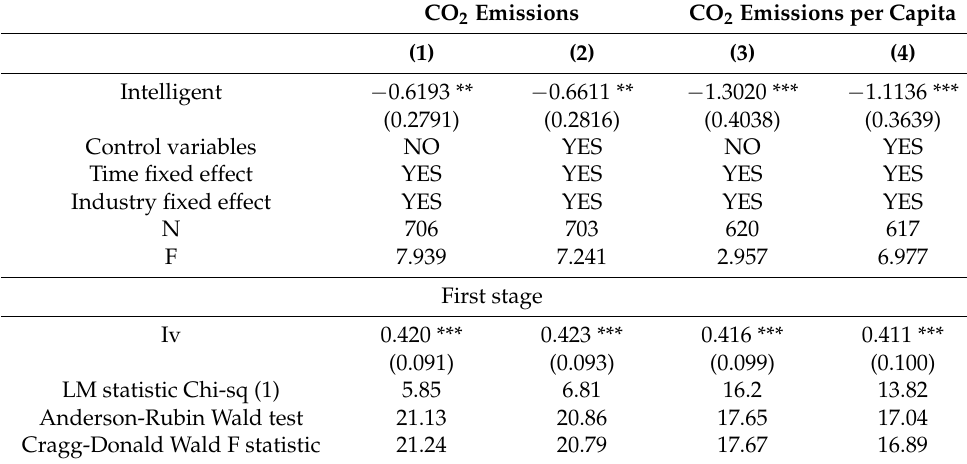
Table 9. Instrumental variable test.